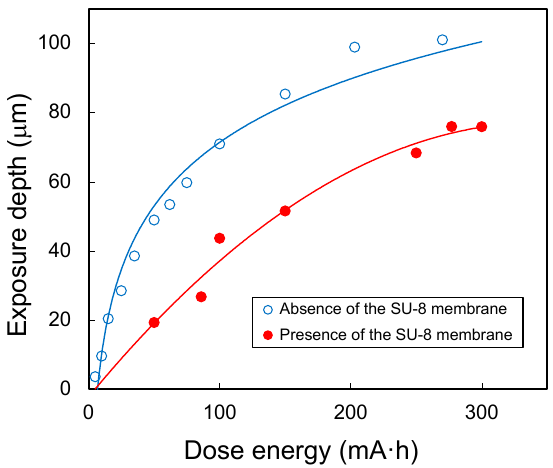
Figure 6. Exposure depth of PMMA sheet in cases of the absence and presence of the SU-8 membrane depended on the dose